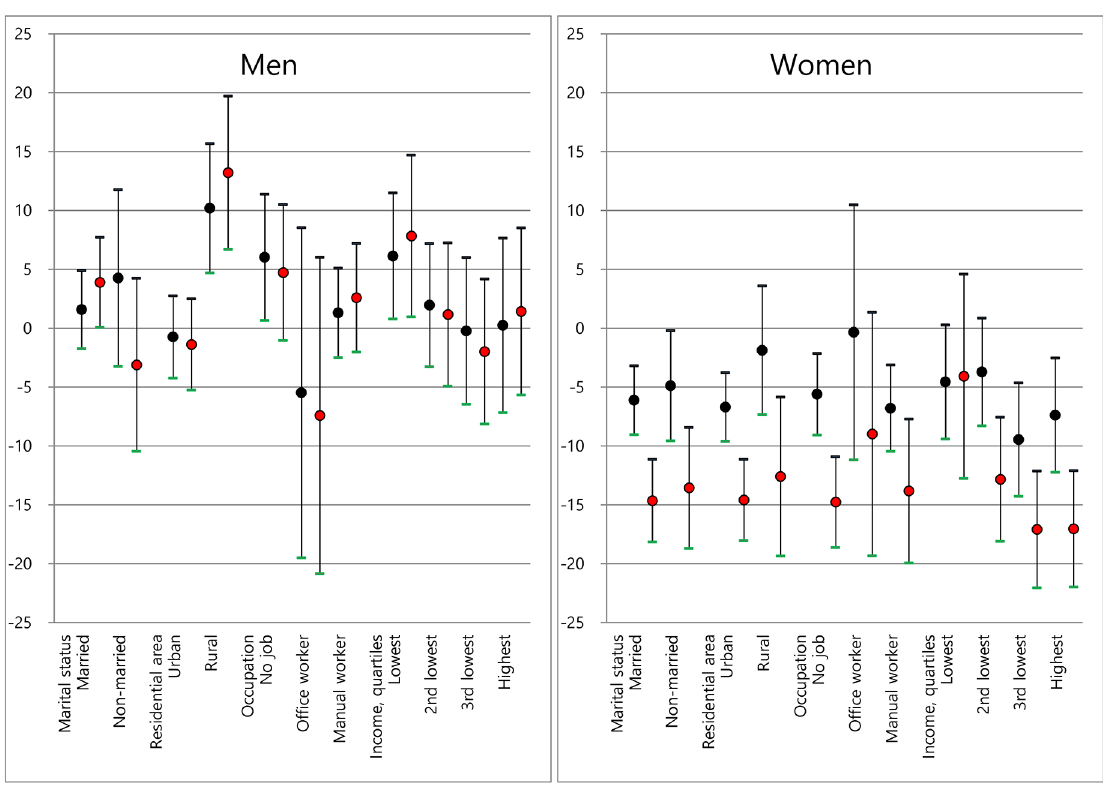
Fig 1. The percentage change in an individual’s predicted probability of being obese (its 95% CIs), if the individual belonging to a socioeconomic status indicator group would increasethe individual’s